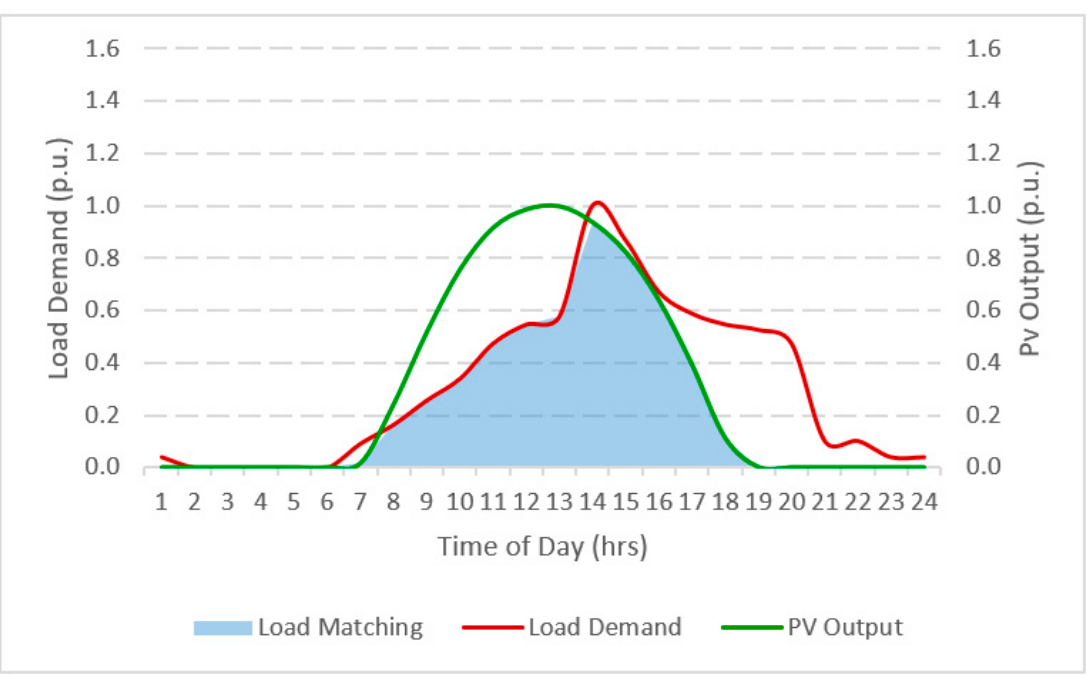
Figure 12. Load matching in 2020.